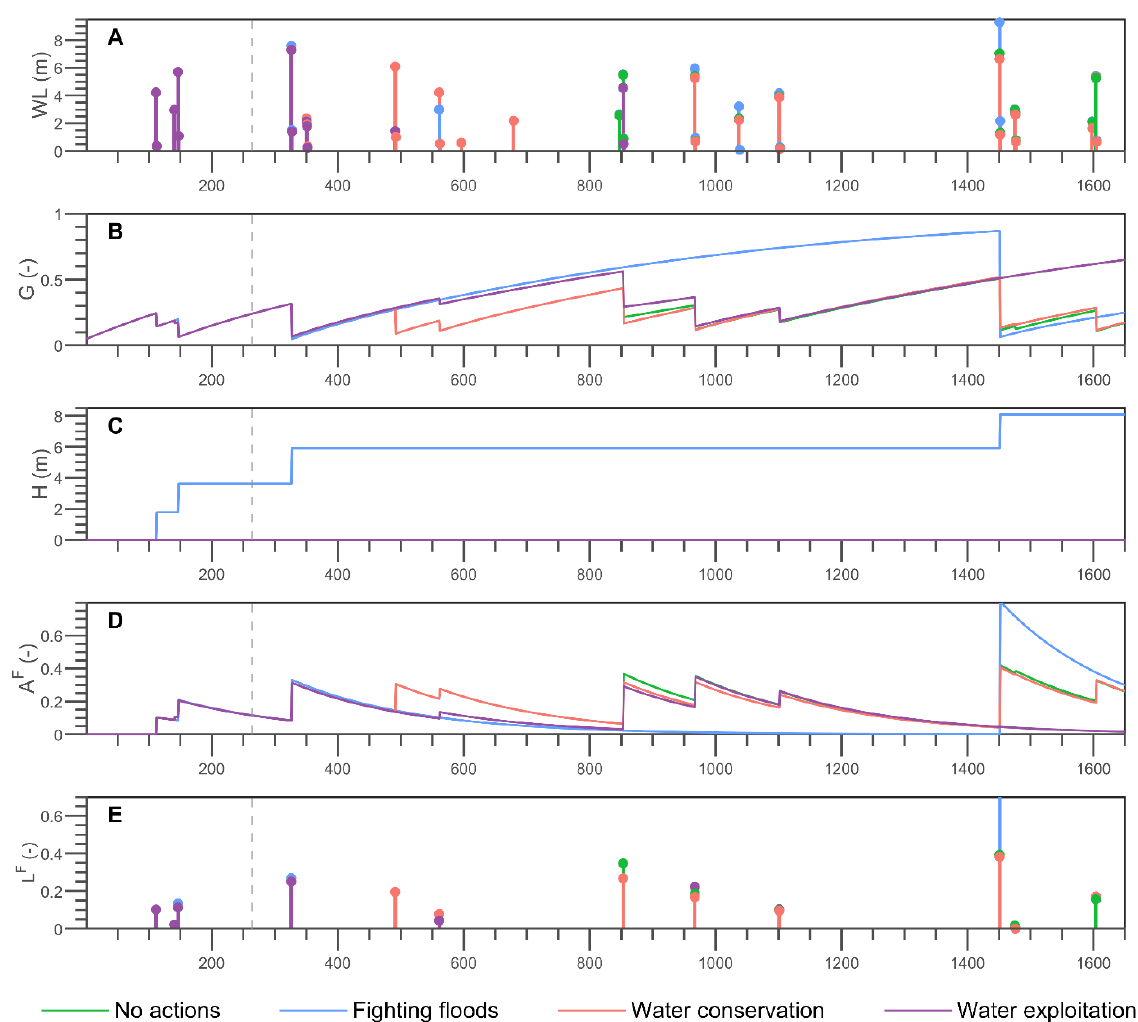
Figure A12. Flooding-based variables of the synthetic experiments additional scenario #2 considering dam construction and human-flood interactions with the four water management strategies introduced in this study. (A) Water level (WL), (B) proportion of population in floodplain (G), (C) levee height (H), (D) flood awareness (AF), and (E) flood losses (LF). The grey dashed line indicates the construction of the Wivenhoe